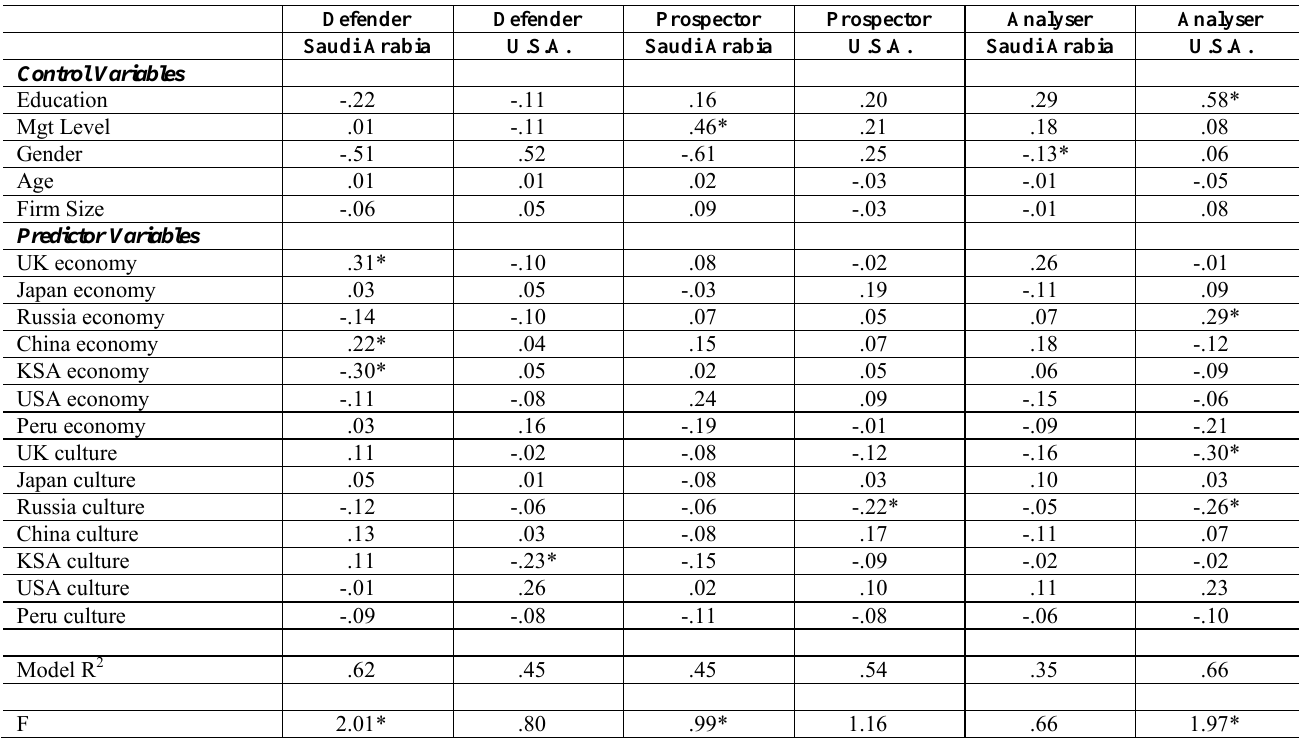
Table 2: Regression results: Dependent variables: Strategic orientations Defender Defender Prospector Prospector Analyser